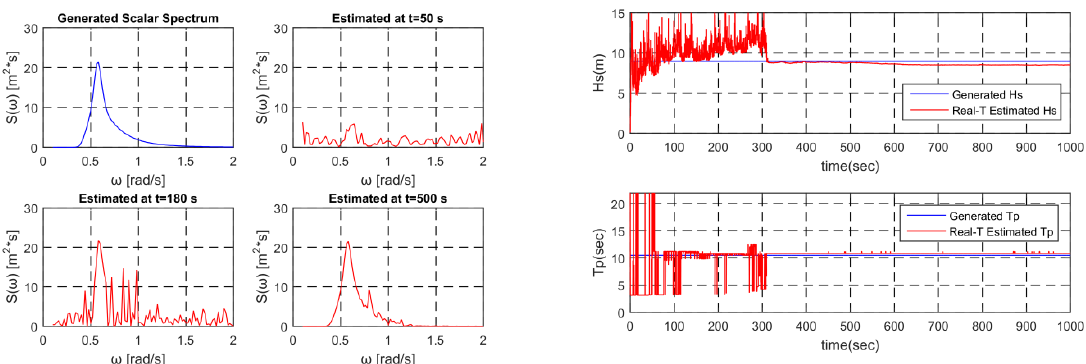
Figure 24. Generated and estimated spectrum / Evolution of parameters (Sea sate 3, Hs = 9 m, Tp = 11 s).